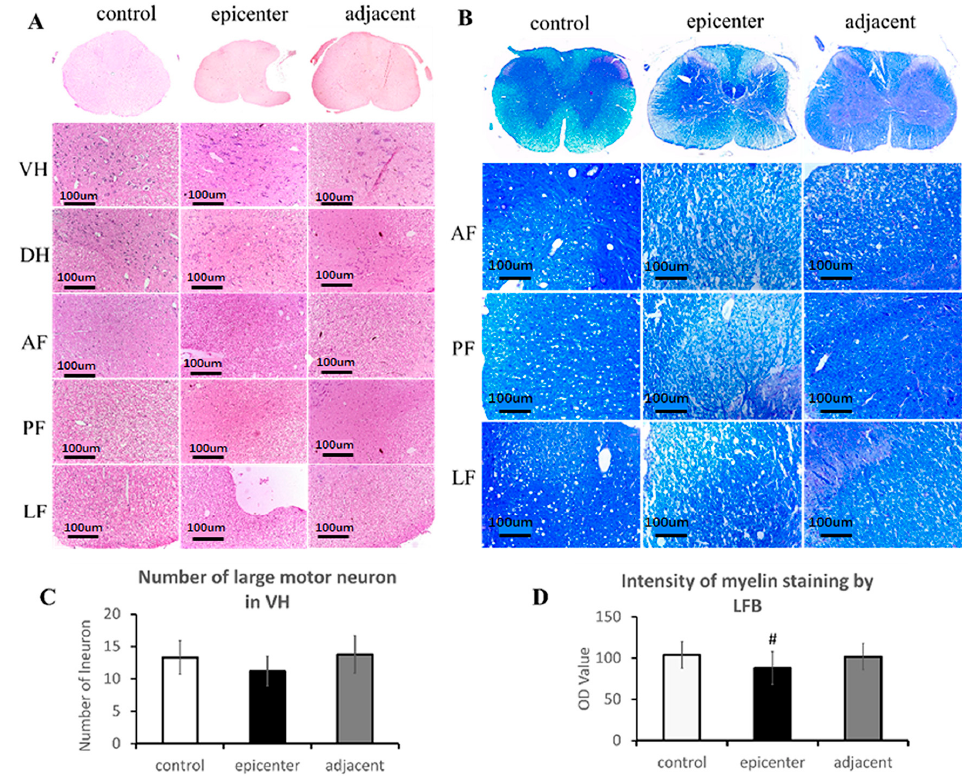
Figure 3. Histopathological evidence of neuronal and axonal degeneration. ( A ) Chronic compression caused neuronal degeneration in VH and DH and neural fiber disorganization in AF, PF and LF (HE staining). ( B ) Chronic compression caused axonal demyelination in AF, PF and LF (LFB staining). Evident vacuolated change of neural fiber with significant reduction of myelin staining intensity demonstrated axonal demyelination in the compressive epicenter. ( C ) No significant difference in large motor neuron number was found among the three groups. ( D ) Milder axonal demyelination was also seen in the adjacent level and no significant difference of myelin staining intensity was found compared with control group. Note: “VH”, ventral horn; “DH”, dorsal horn; “AF”, anterior funiculus; “PF”, post funiculus; “LF”, lateral funiculus; “#”, different from the control group ( p < 0.05).